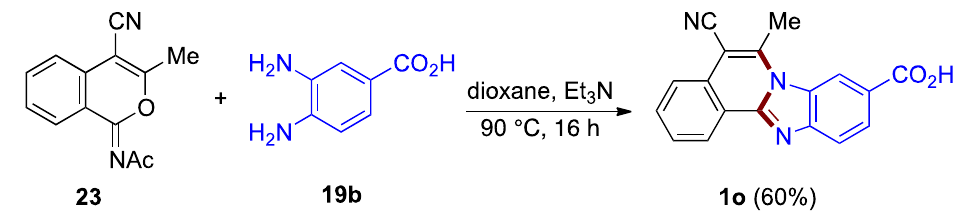
Figure 17. One-pot tandem cyclization leading to 5-amino- and 6-carbonyl functionalized benzimi- dazo[2,1- a ]isoquinolines 1n .